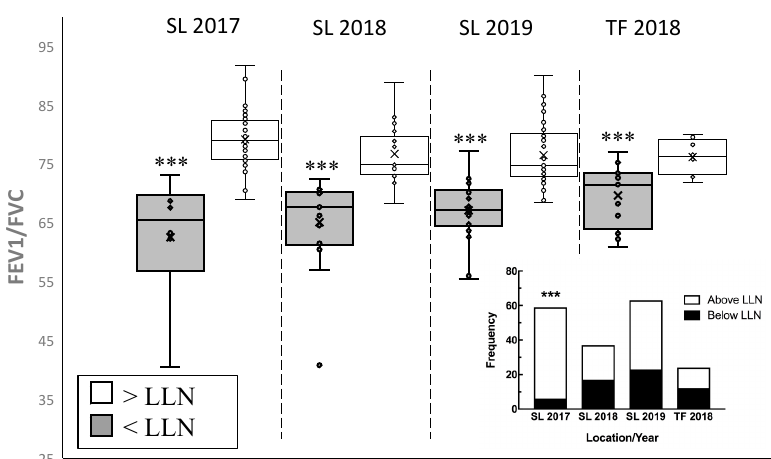
Figure 3. Community members falling below lower limit of normal for FEV 1 . To determine clinically significant decreases in lung function, individual FEV 1 values are compared to the lower limit of normal (LLN) based on individual parameters (height, sex, age). LLN was calculated using z-scores (z-score < − 1.64) and the following equation: (measured-predicted)/standard deviation. All three years of assessments in Seeley Lake and the one year in Thompson Falls found the average FEV 1 values for the participants below LLN to be significantly lower that of the rest of the cohort. In addition, there is a significant increase in proportion of participants falling below the LLN, contrasted to the 2017 SL values, as shown in the inset contingency table ( n = 24 − 59, *** p < 0.001).